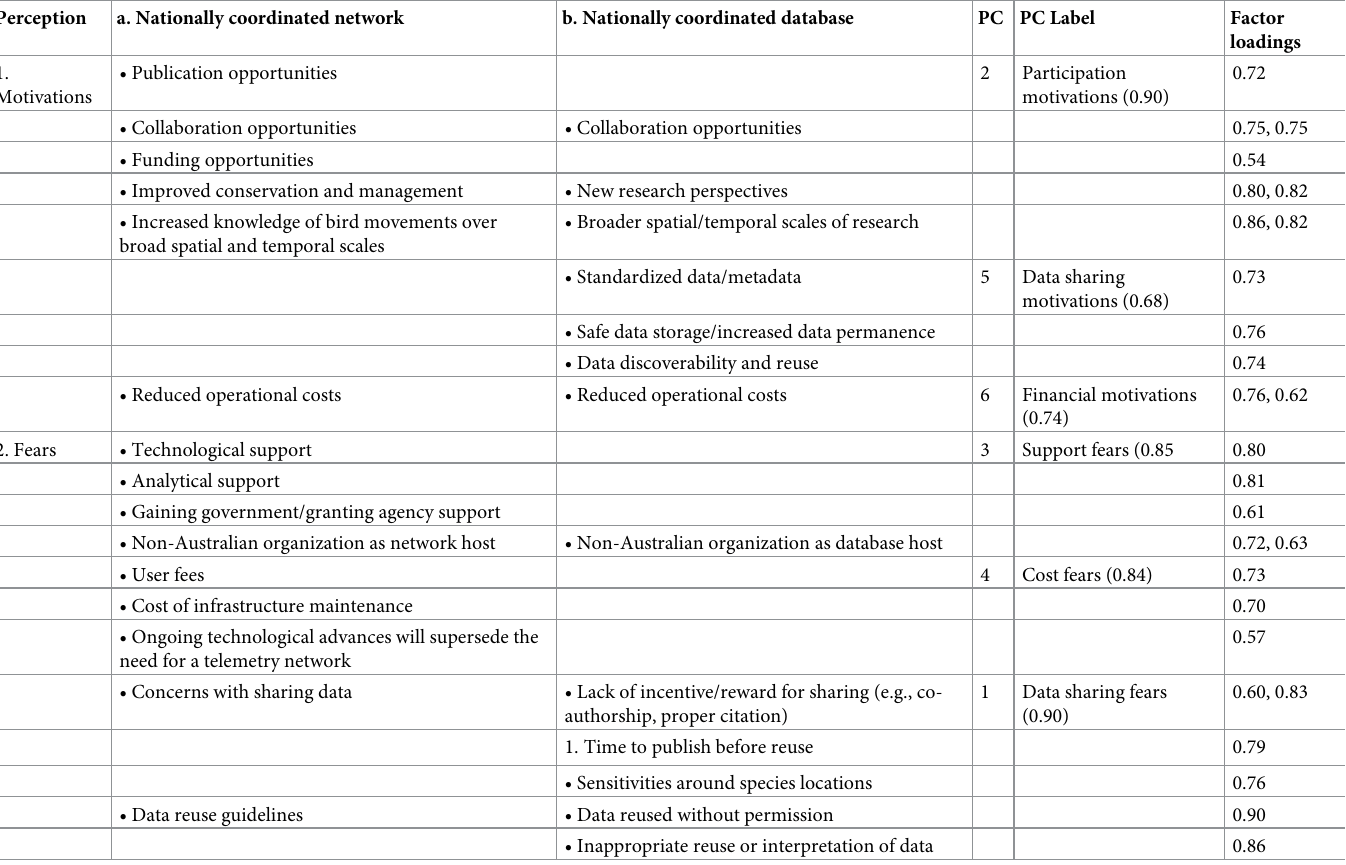
Table 1. Survey participants ranked perceptions of various 1) motivations and 2) fears of a) participating in a nationally coordinated network and b) sharing data with a nationally coordinated database.